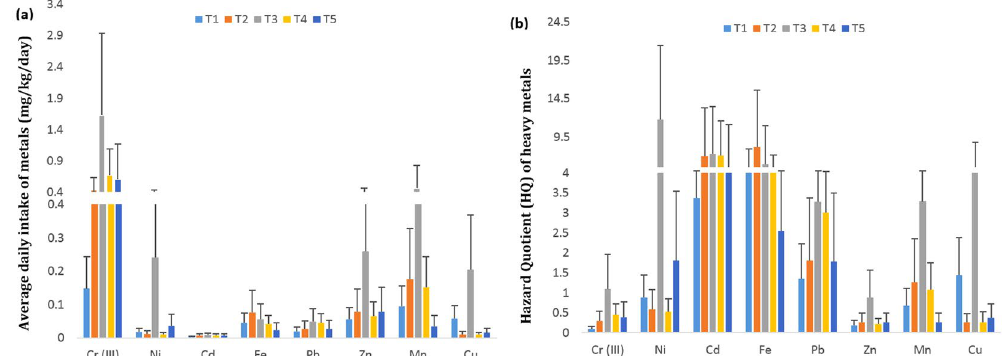
Figure 4. Health risk assessment associated with heavy metals intake through industrial dust exposure. ( a ) Average daily intake of metal (ADI), ( b ) hazard quotient (HQ) of heavy metals in the exposed workers from five different leather industries (T1, T2, T3, T4 and T5) of Sialkot, Pakistan. Note: HQ for Cr(VI) was reported highest among all the heavy metals in this study, due to large values of HQs for Cr(VI), they were not included in this chart to make this figure